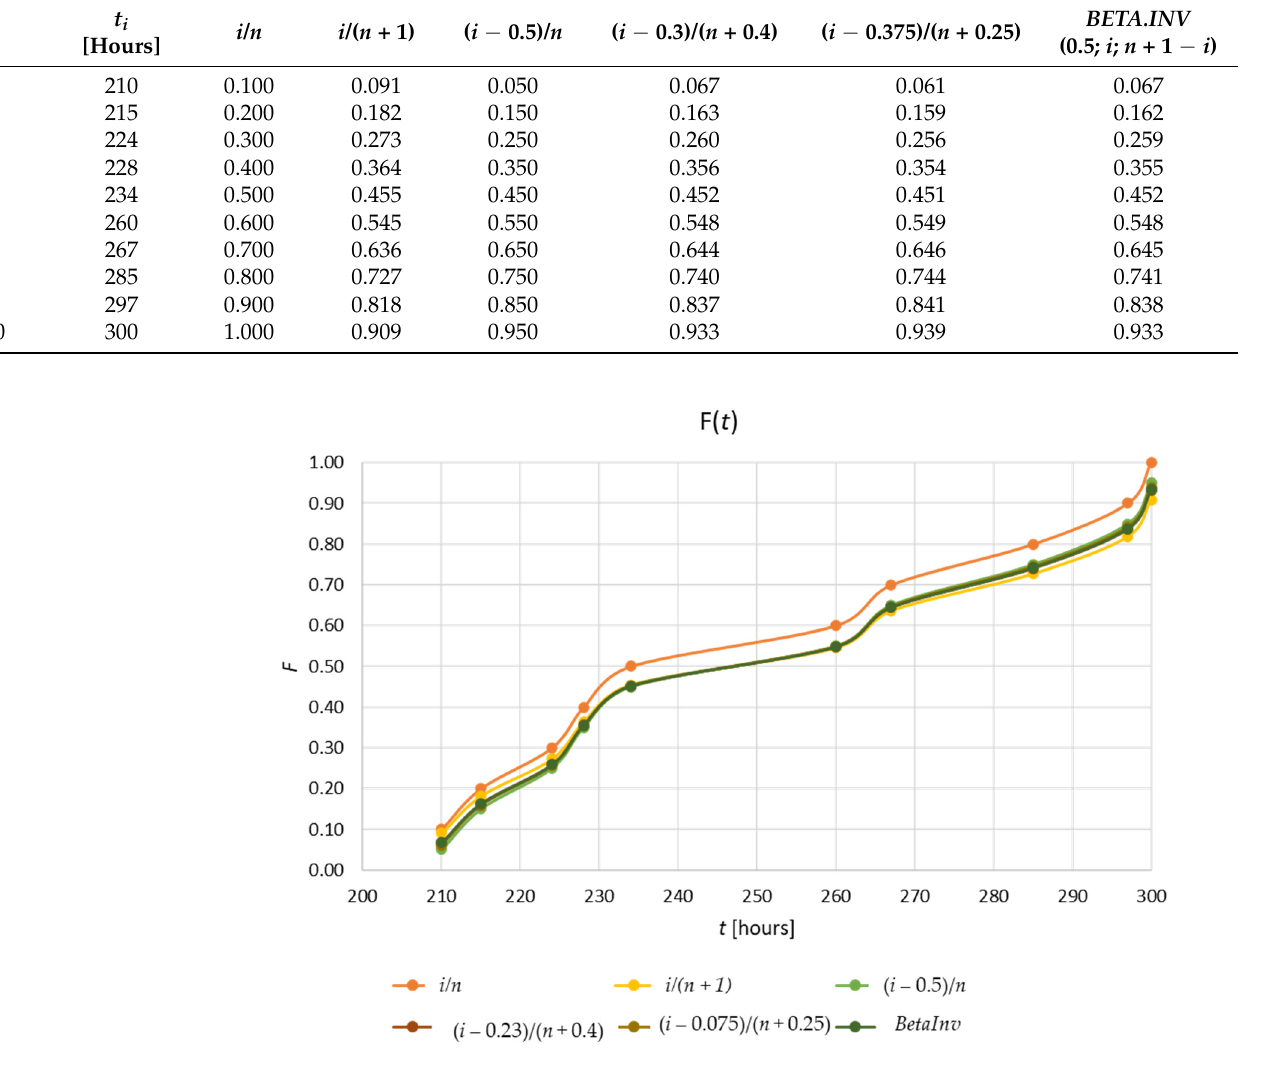
Figure 2. Graphs of the distribution function F ( t ) that were obtained by various estimators.